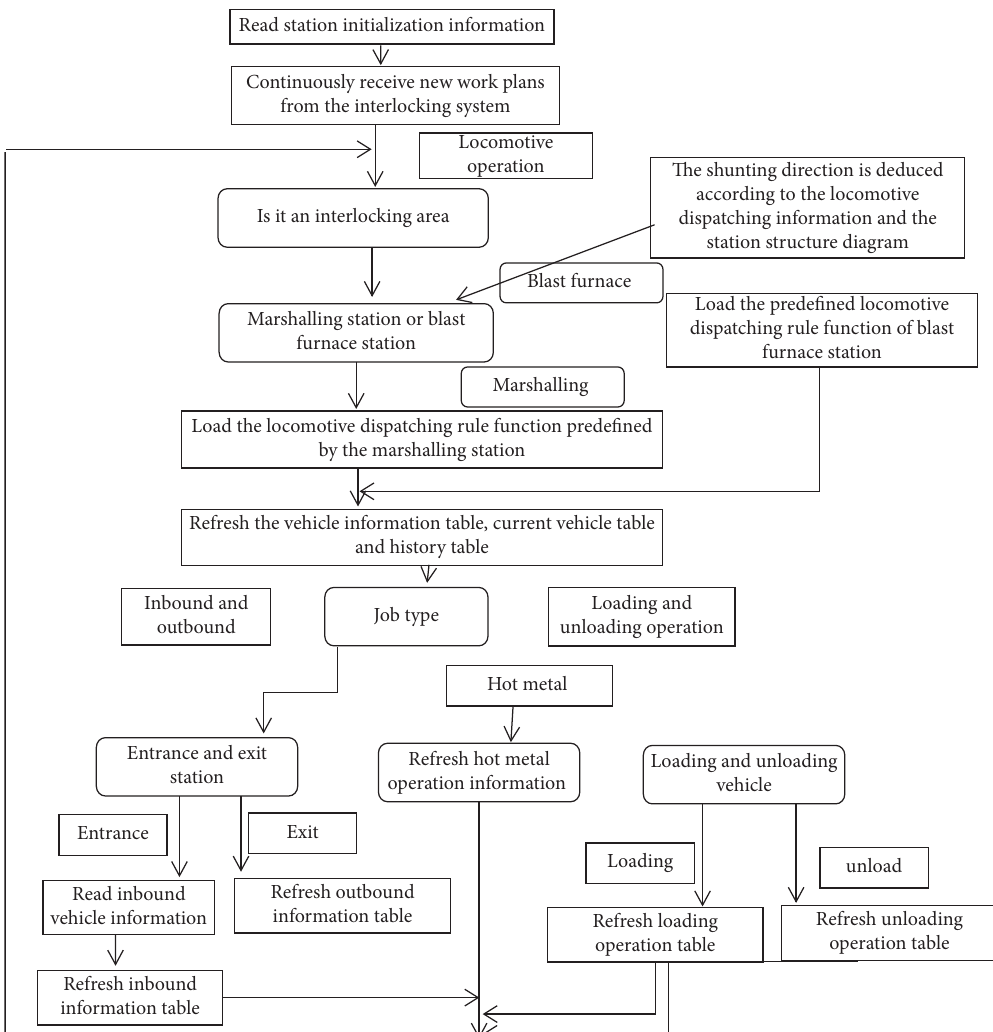
Figure 7: Schematic flowchart of the tracking calculation subsystem.